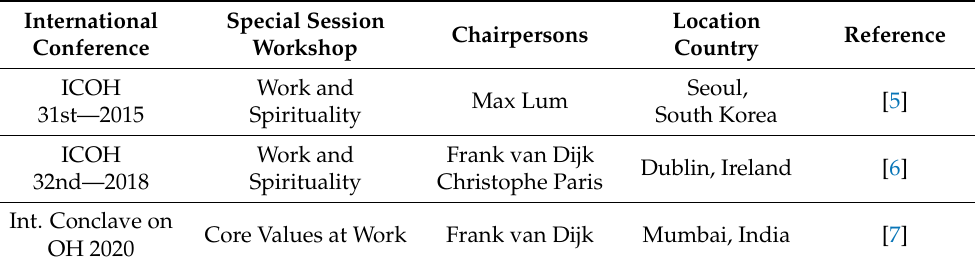
Table 1. Summary of the international ICOH sessions. These sessions were dedicated to spiritual and core values at